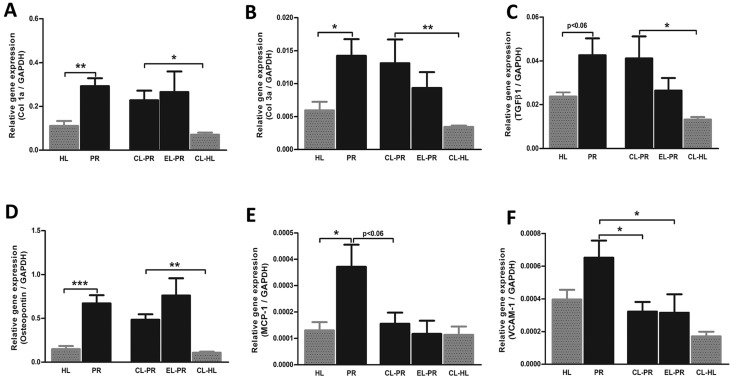
Effects of CL treatment on mRNA expression of fibrotic and inflammatory markers. Targeting macrophages by CLs did not markedly alter the mRNA expression of the fibrotic markers collagen I (α1), collagen III (α1) and TGF-β1 compared with non-treated proteinuric rats (A-C). The CL intervention strongly prevented the increase of VCAM-1 mRNA expression in proteinuric rats (F). MCP-1 expression was non-significantly (P<0.06) reduced by CL treatment (E), whereas osteopontin expression was not influenced by the treatment (D). HL, healthy; PR, proteinuric untreated; CL, clodronate liposome; EL, empty liposome. *P<0.05, **P<0.01, ***P<0.001.